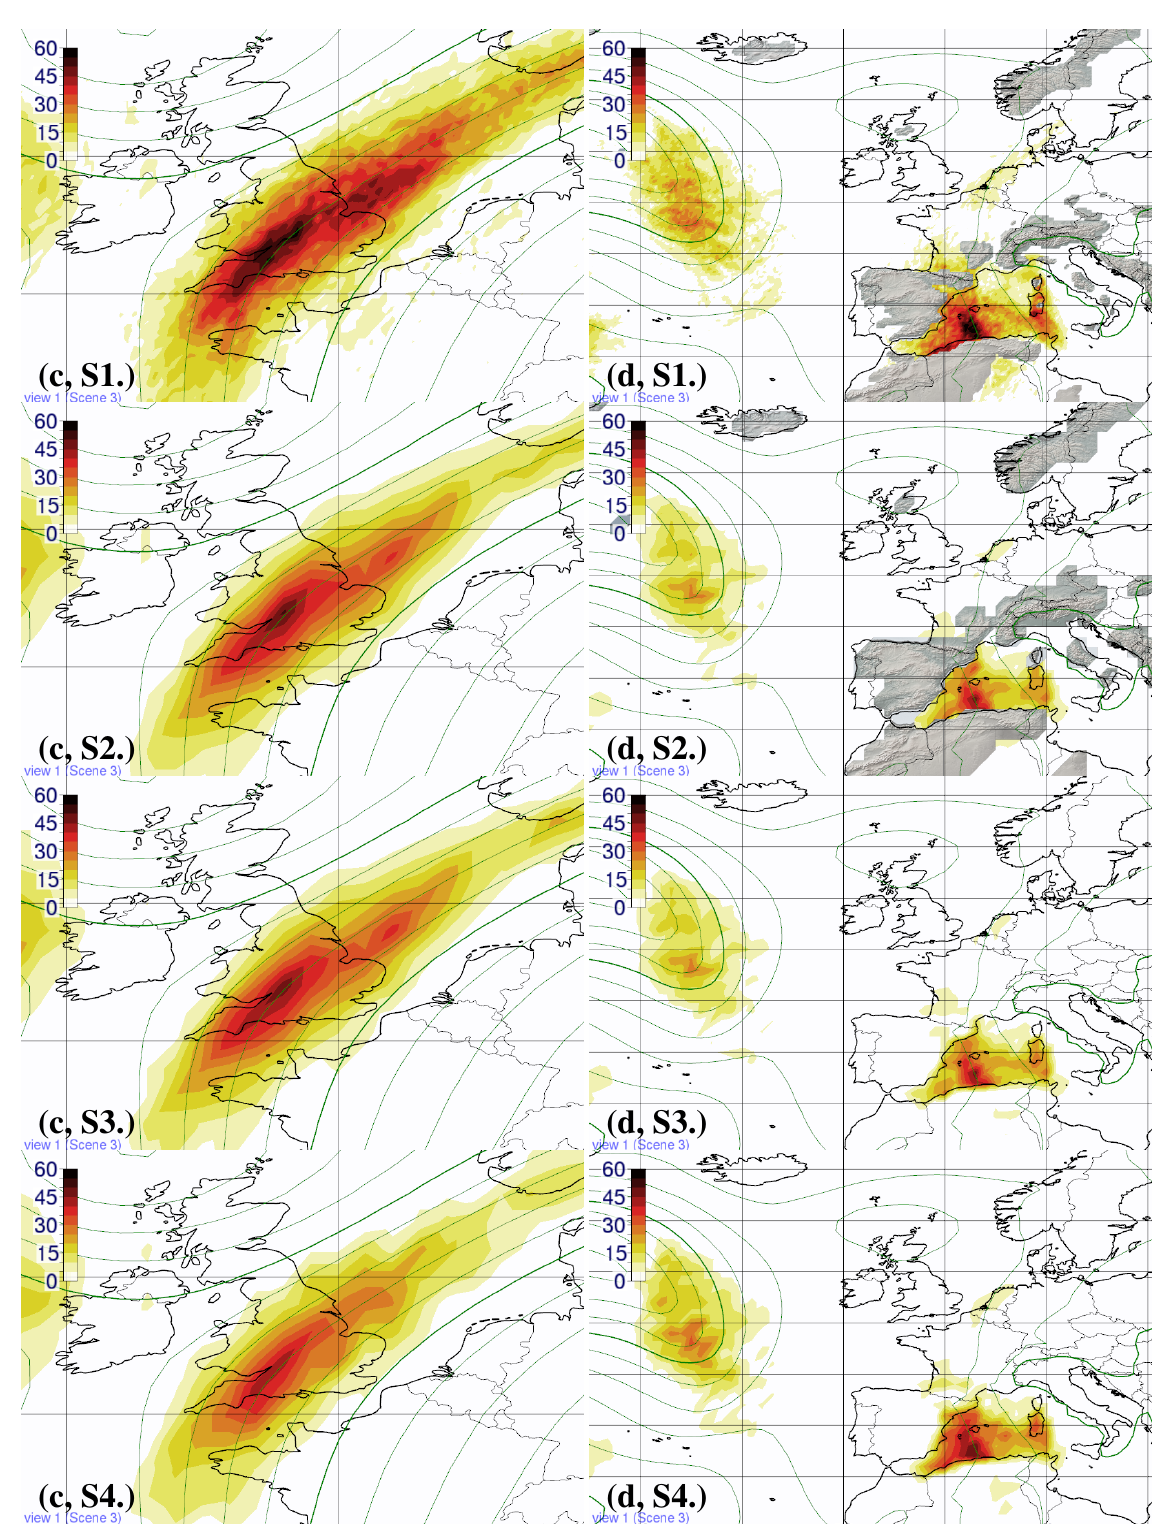
Figure 6. Same as Fig. 5, but showing (c) horizontal section of p( WCB ) at 410hPa; (d) horizontal section of p( WCB ) at 950hPa; colour coding in %; green contour lines show ensemble mean geopotential